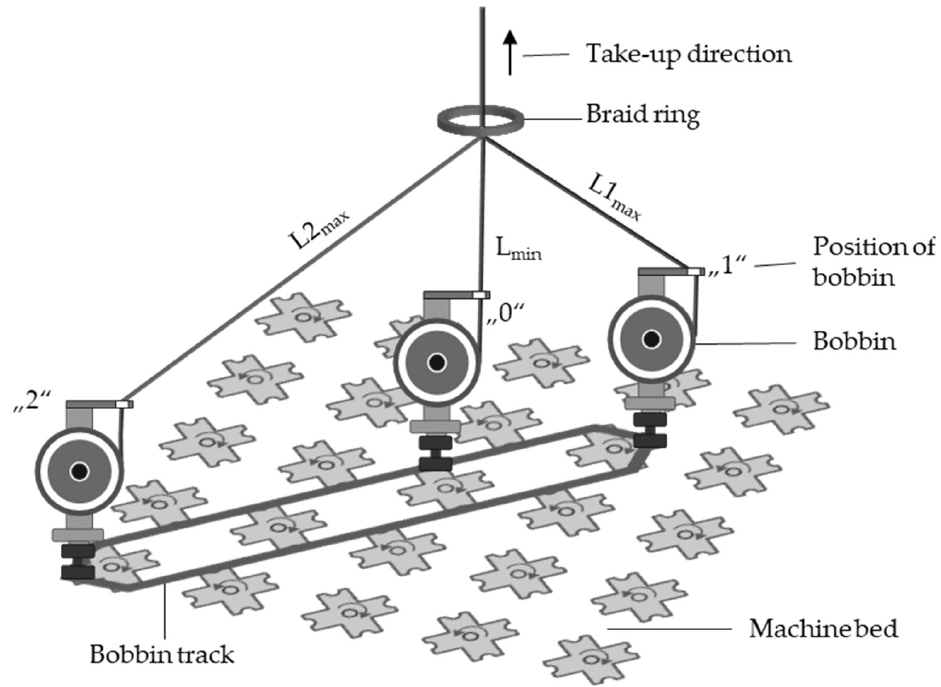
Figure 3. Illustration of yarn length compensation in 3D braiding technology depending on the bob- bin’s position on the machine bed.